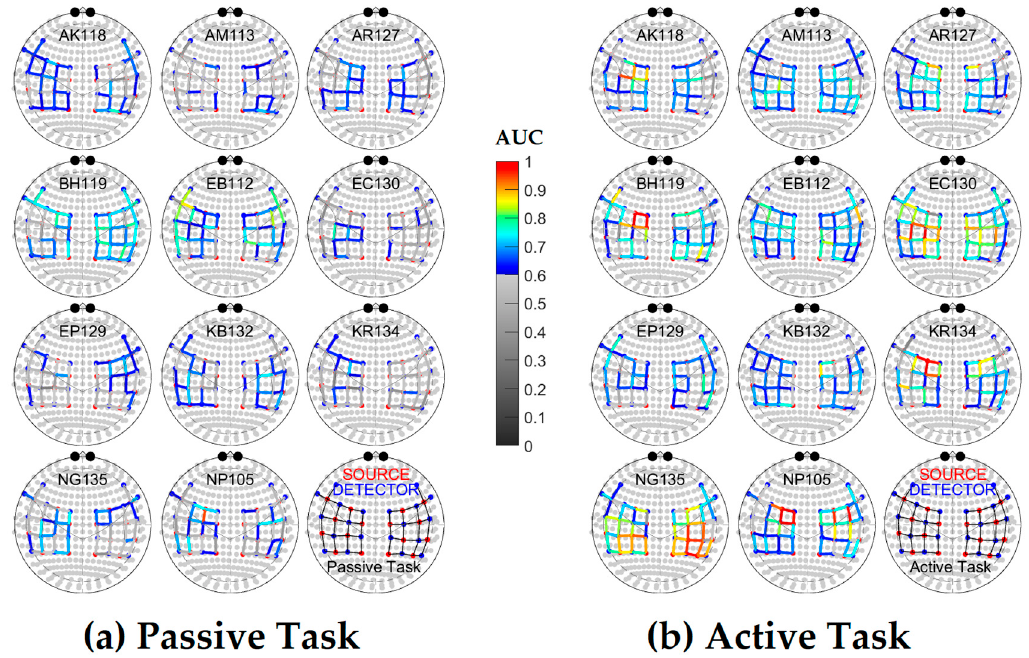
Figure 2. Stim-on vs. Stim-off discriminatory contribution of each link across 11 participants when both HbO and HbR are fed to the RDA classifier. Channels with AUC > 0.6 where chosen for feature Table 1. Percentage of channels per subject remaining in the feature space by meeting the AUC > 0.6